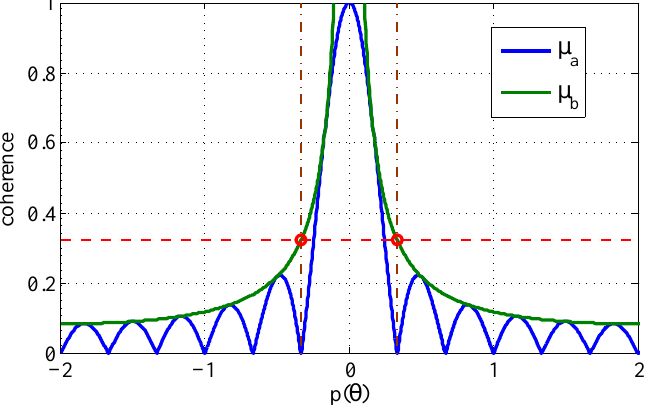
Figure B1. Mutual coherence of the array manifold matrix and its upper